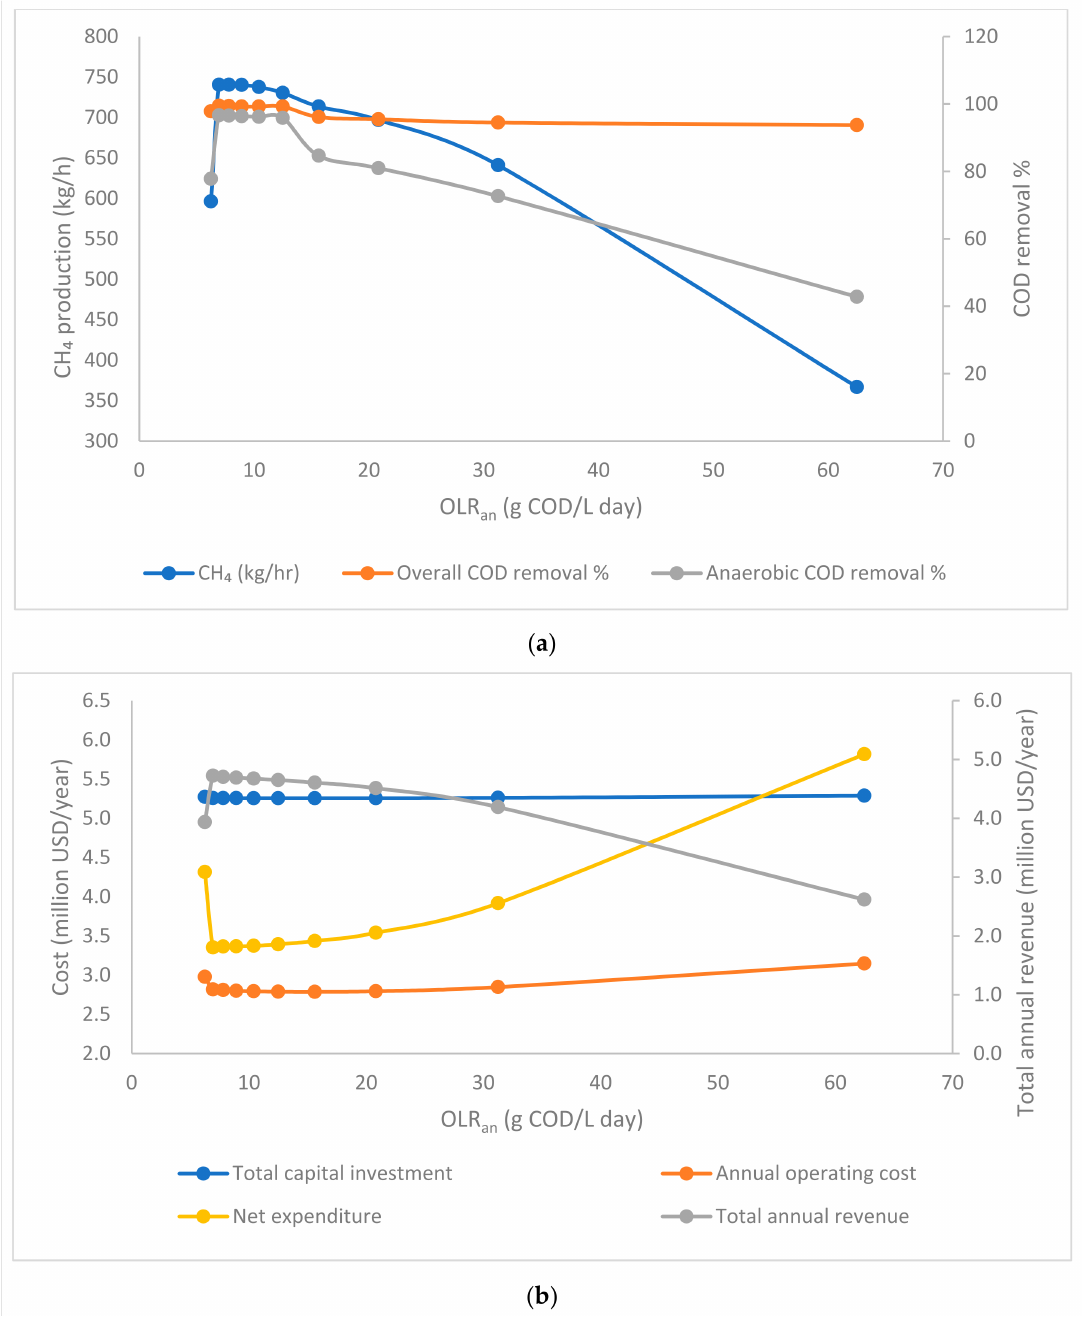
Figure 4. ( a ) Effect of OLR against methane production and COD removal % ( b ) Effect of OLR on economic